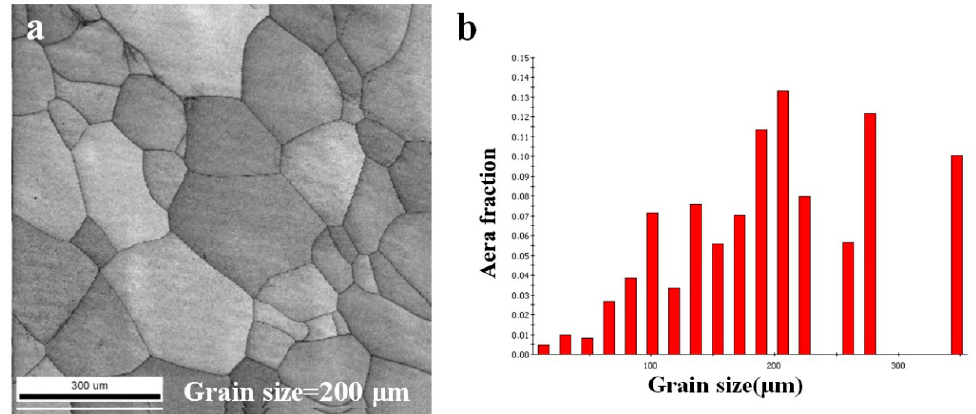
Figure 1. ( a ) Microstructure; ( b ) grain size distribution of the pure Ti sample used in this study.